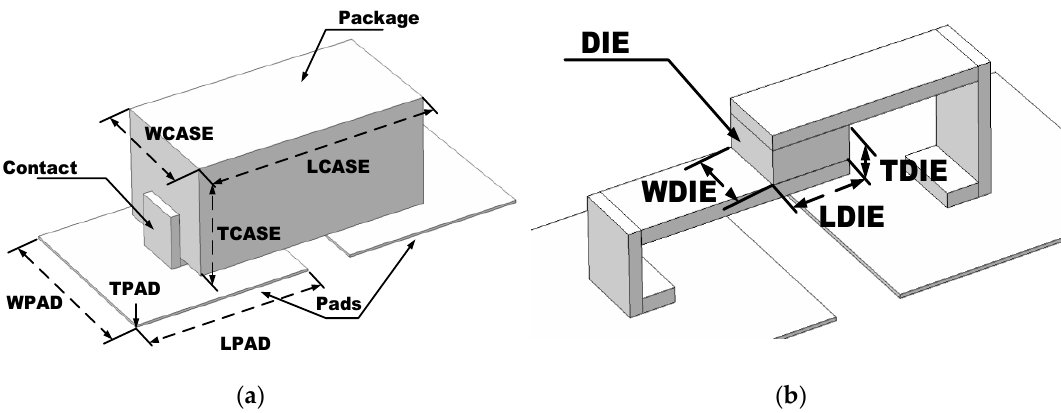
Figure 6. Generalized Model of Semiconductor Diode in SMD Package ( a ) Package/PADS; ( b ) DIE. Next part of simulation model design is definitions on the boundary settings, which are described in Table 1. Table 1. General Boundary Settings.